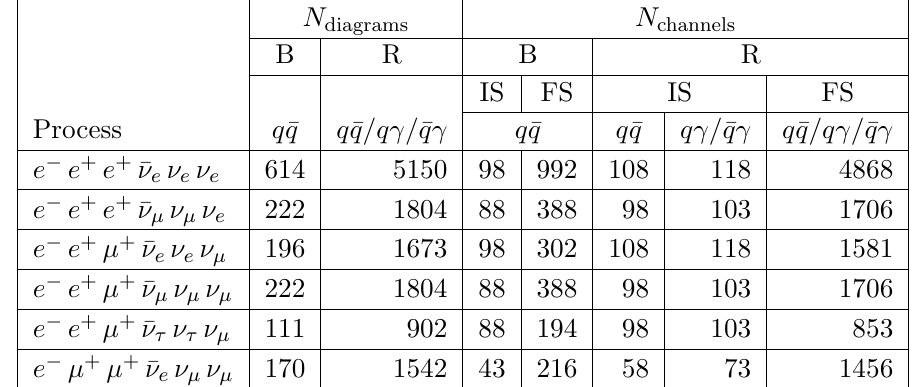
Table 2 . Number of Feynman diagrams in the Born process (B) and the real emission correction (R) (numbers quoted for both the q (cid:22) q and q(cid:13)= (cid:22) q(cid:13) individually) and the number of associated initial state (IS) and (cid:12)nal state (FS) phase space channels, split by their partonic intial